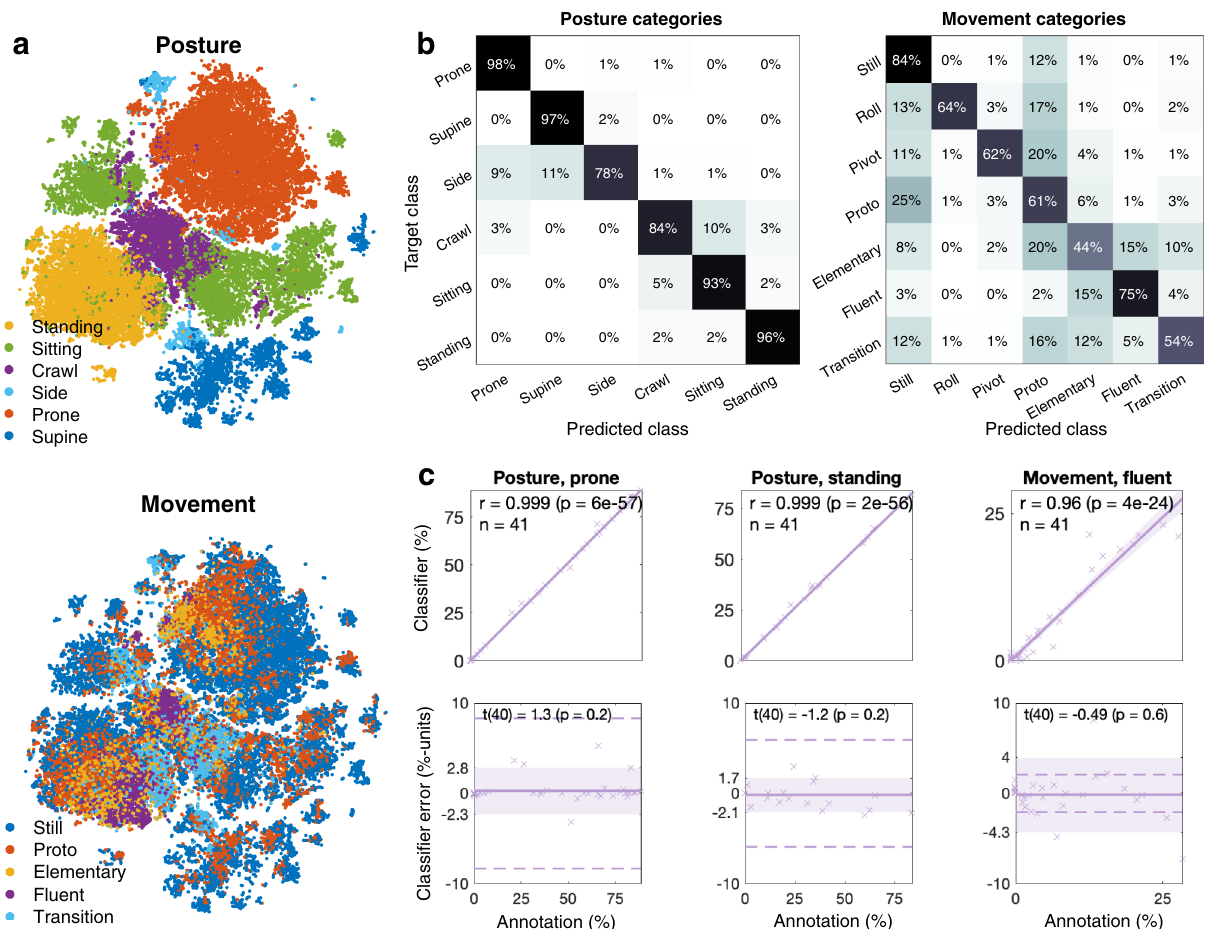
Fig. 4 Classi fi er development and computational analyses of MAIJU recordings. a t-SNE plots obtained from self-supervised feature embeddings (CPC) with color codings for posture (top) and movement (bottom). Note the clear clustering of posture categories, while the movement categories show relatively more dispersion. b Confusion matrices showing recall values (in %) of the algorithm output ( “ Predicted class ” ) and the compounded human expert annotations ( “ Target class ” ). Note the high numbers in the diagonal line indicating high agreement. c Comparison of quanti fi ed motor ability between the classi fi er and human annotations ( N = 42). In the upper graphs, the scatter plots show the proportion of time spent in the given postures or movements as estimated by the classi fi er algorithm (Y-axis) and the human annotations (X-axis). The Pearson ’ s r (and its p value) denotes the linear correlation between the proportion values. Below, the Bland – Altman plots of annotations vs classi fi cation errors are shown for assessing whether the classi fi cation errors have a systematic bias and/or are dependent on the amount of posture/movement identi fi ed by the algorithm. The stippled lines depict an average one-month developmental change (percentage points per month) as taken from a linear regression model fi tted between the age (in months) and the given motor ability occurrence (cf. Fig. 2c). Note that 100 and 88% of the measurements in posture and fl uent movement categories, respectively, are within these stippled lines. The shaded zone depicts the 95% con fi dence interval (in percentage points) of the classi fi er error. The t value depicts the two-tailed t -test result (with 40 degrees of freedom) on the null hypothesis that the error has a mean of zero; this shows that the proportional estimates are